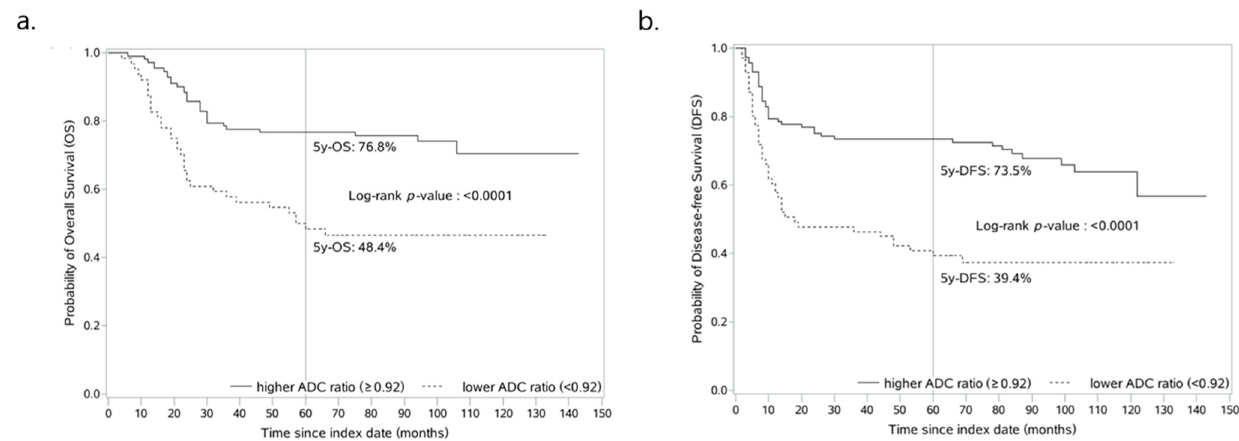
Figure 5. ADC ratio-based prognostic model reliably predicts OS and DFS of patients with OTSCC. Kaplan-Meier curves for estimating the probability of ( a ) overall survival and ( b ) disease-free sur- vival in patients with higher ADC ratio ( ≥ 0.92) vs. lower ADC ratio (<0.92). ADC, apparent diffusion coefficient.